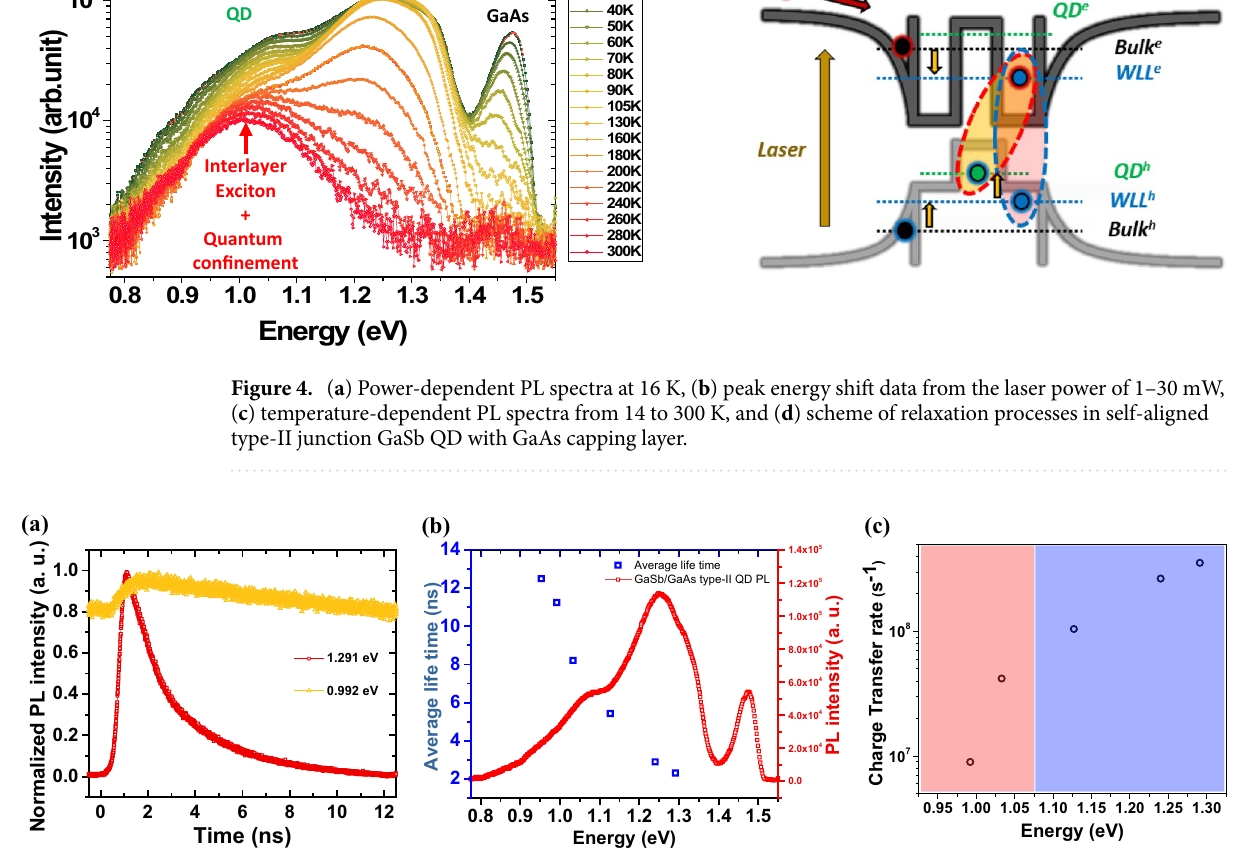
Figure 5. ( a ) TRPL spectra at 300 K and ( b ) average lifetime fitting data based on TRPL. ( c ) Many-state Marcus model fitting data of GaSb QD from 0.75 to 1.55